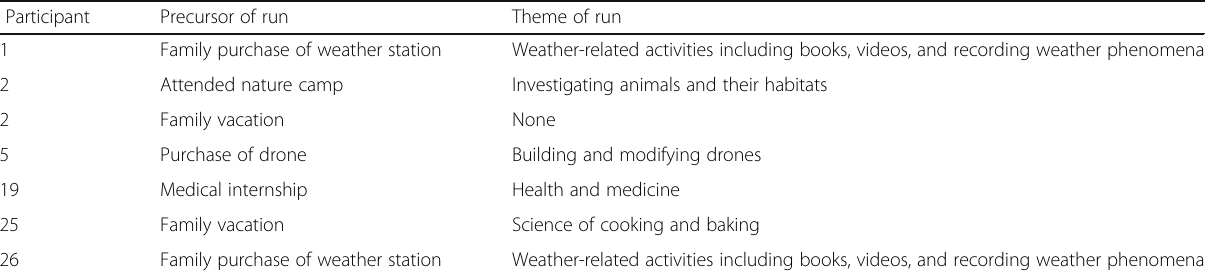
Table 4 Descriptions of topical run and run check-in patterns Participant Precursor of run